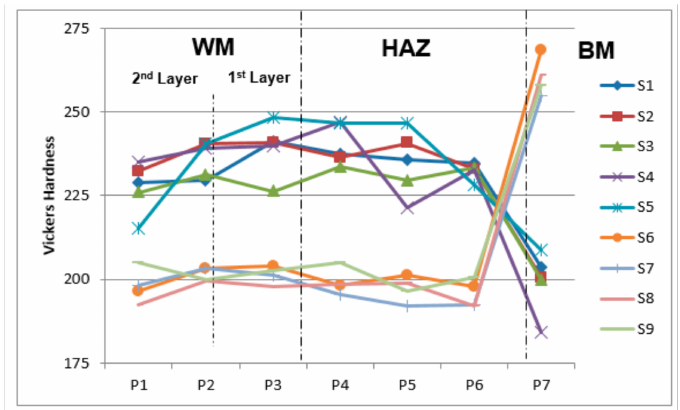
Figure 7. Comparison of macro-hardness in the cross-section